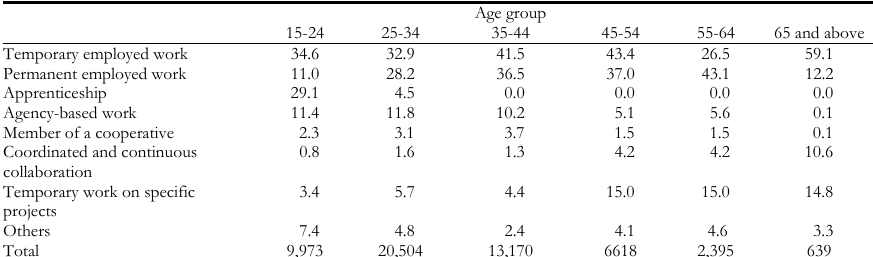
Job placements according to contract type and age group during the first half of